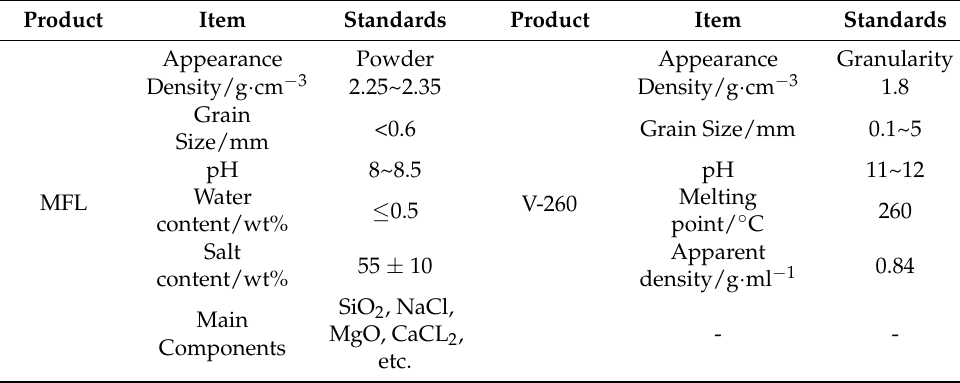
Table 2. Salt-storage material quality and technical